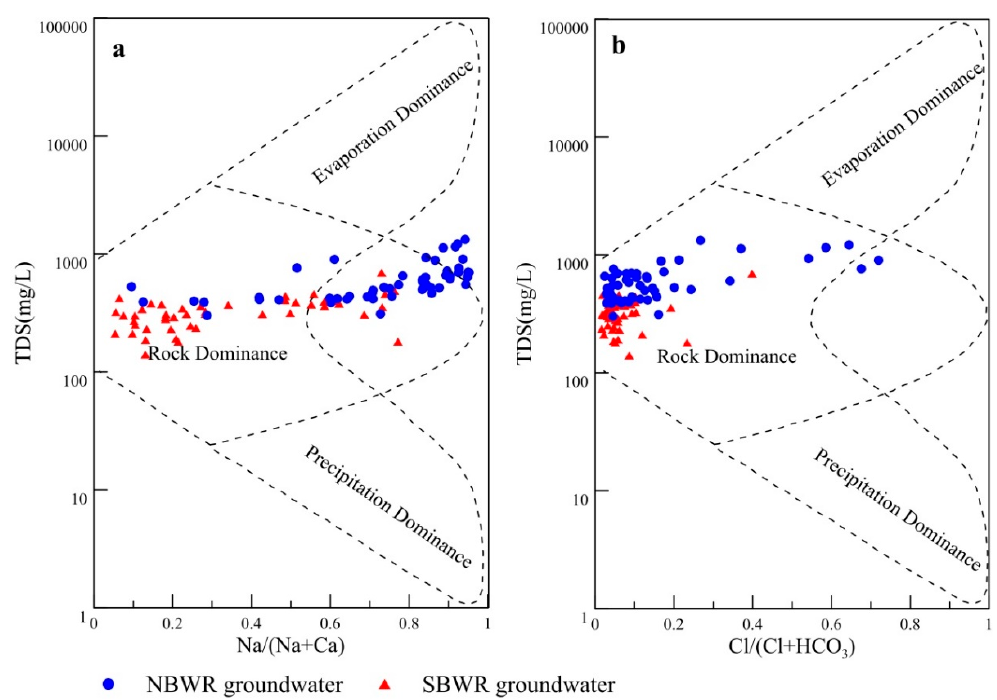
Figure 3. Gibbs diagrams indicating the groundwater natural evolution mechanisms ( a ): TDS vs. Na / (Na + Ca); ( b ): TDS vs. Cl / (Cl + HCO 3 ).